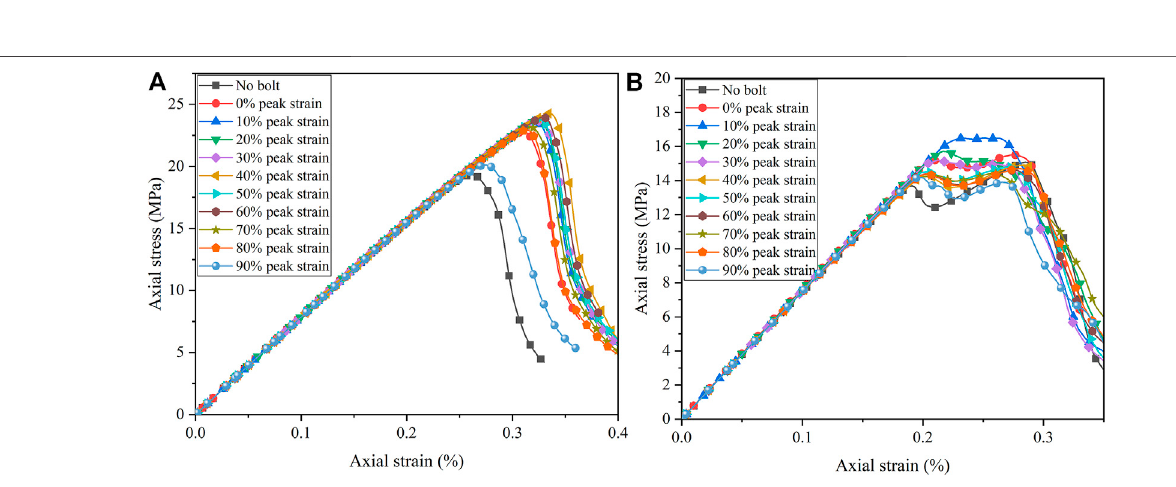
Frontiers in Earth Science |